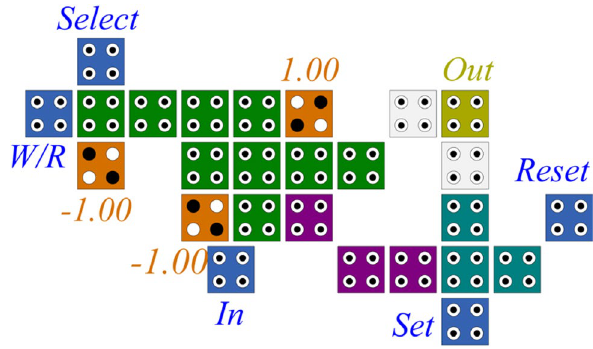
Fig. 7 The developed 1-bit RAM circuit in